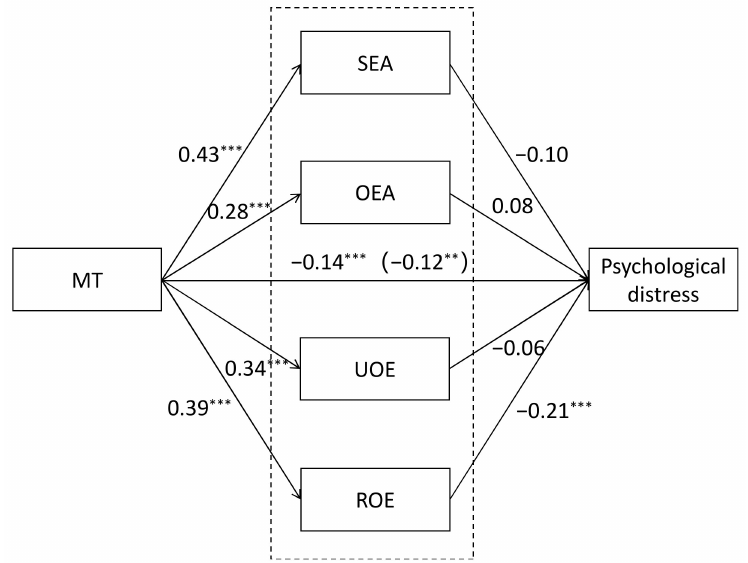
Figure 2. Multiple mediator model examining the direct and indirect relation of MT and psychological distress. Numbers in parentheses represent indirect e ff ects. Note: all regression coe ffi cients are standardized. SEA, ROE, UOE and OEA are the subscales of the Wong Law Emotional Intelligence Scale. ** p <